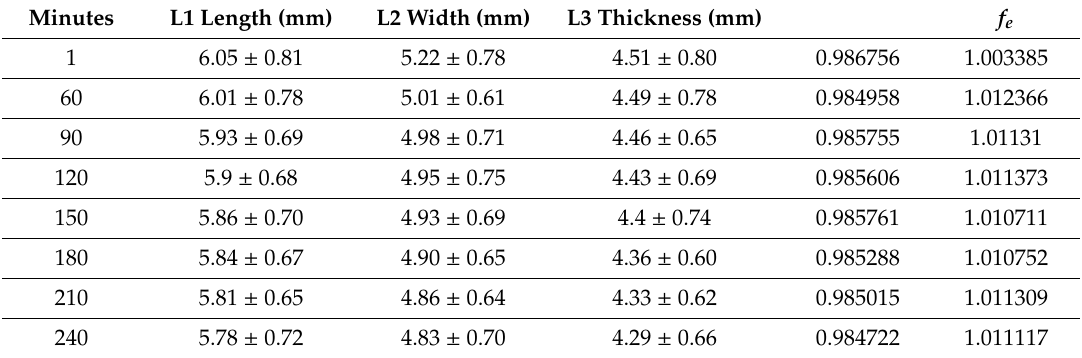
Table 4. The physical characteristics of the solid matrix particles measured during the CPE